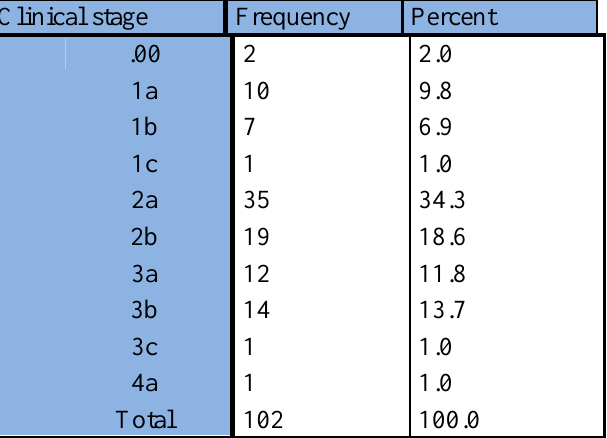
Table 2 The clinical stage of breast cancer cases at diagnosis Clinical